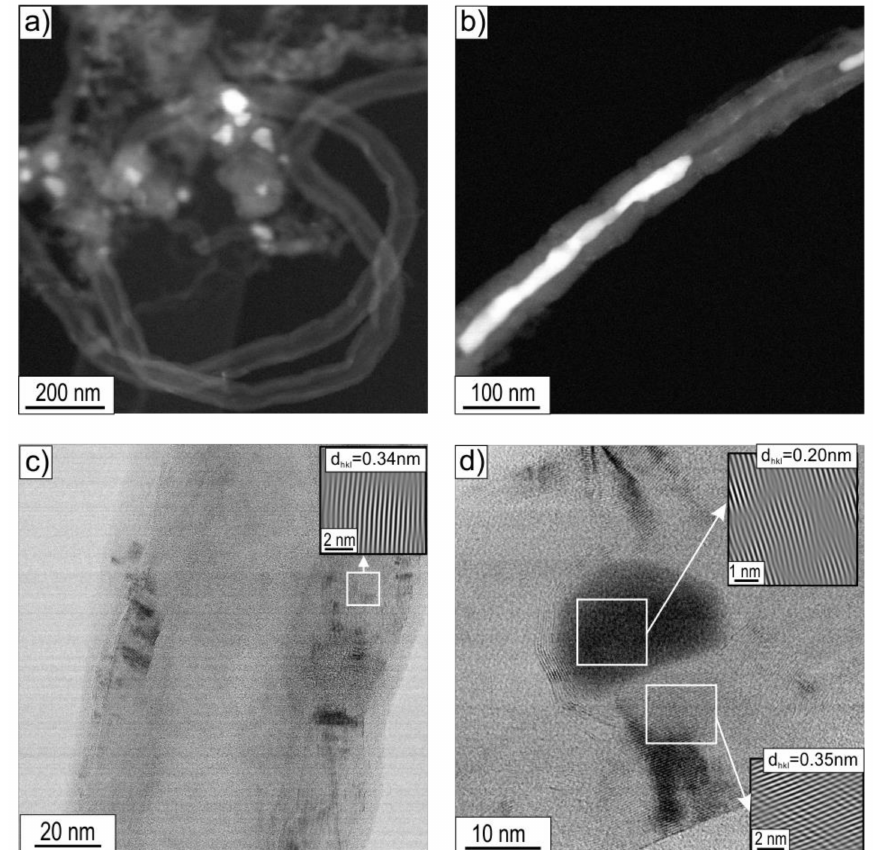
Figure 9. STEM morphology of deposit formed on the Ni 3 Al foils surface after decomposition of ethanol without water steam (mixture #1) at 700 ◦ C: ( a , b ) general view and area of: ( c ) multiwalled carbon nanotube, ( d ) carbon nanofibre with Ni particle inside ( a , b —HAADF mode; c , d —BF mode with the enlarged areas performed using